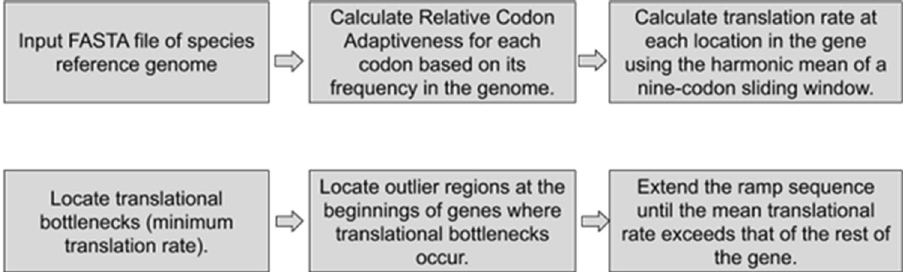
Figure 1. Identifying Ramp Sequences Using ExtRamp. Flowchart for finding ramp sequences using